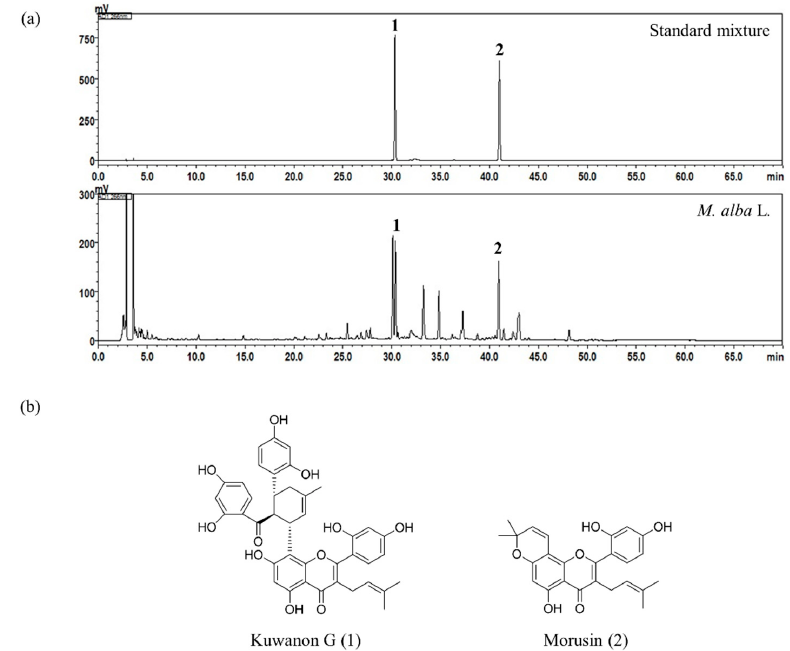
Figure 1. HPLC chromatograms of the standard mixture and M. alba L. sample at a UV detection wavelength of 266 nm ( a ) and chemical structures of the two bioactive marker compounds ( b ).